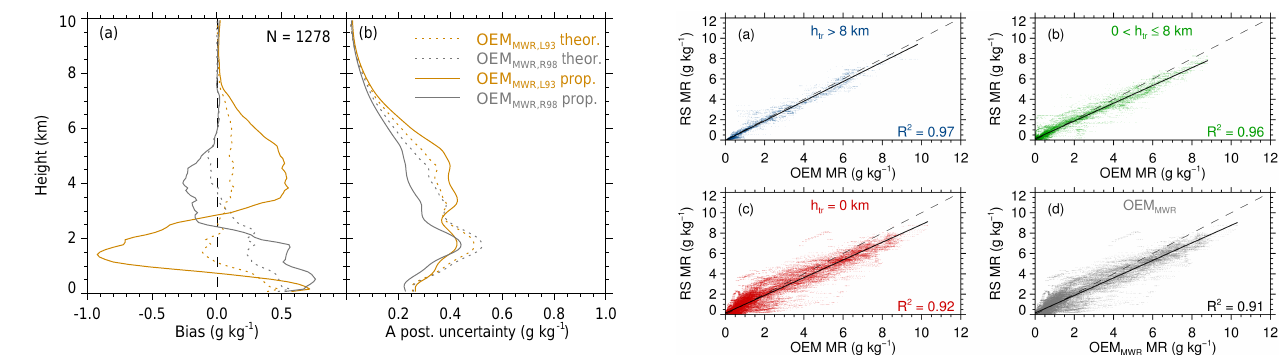
Figure 16. Comparison of optimal estimated (OEM) and ra- diosonde (RS) mixing ratio profiles for the four situations (panels a– d ) given in Table 2. The black solid line indicates the regression